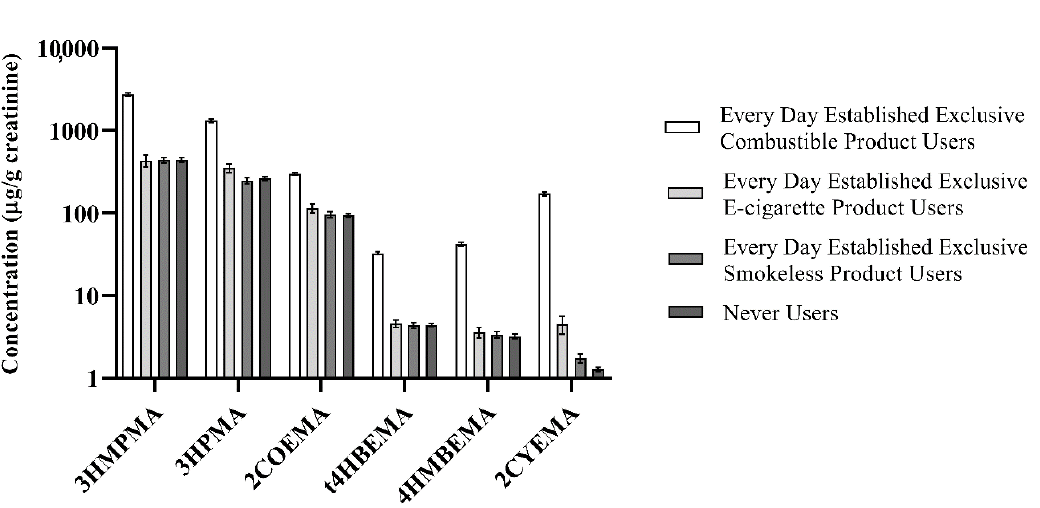
Figure 1. Creatinine-ratioed sample-weighted geometric means (GMs) (95% confidence interval) of selected VOCMs by tobacco user group in the PATH Study Wave 1 (2013–2014).